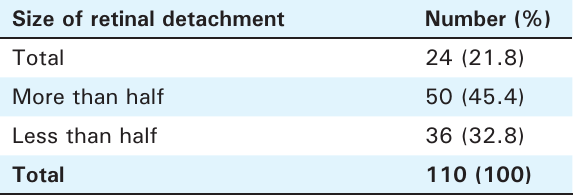
Table 6. Distribution of size of retinal detachment Size of retinal detachment Number (%) Total 24 (21.8) More than half 50 (45.4) Less than half 36 (32.8) Total 110 (100) Scleral buckling was done in the form of radial plomb(20%), circumferential plomb(27.3%), radial plomb with encirclage(23.6%), tyre with encirclage(9.1%) and encirclage only(20%). Similarly, subretinal fl